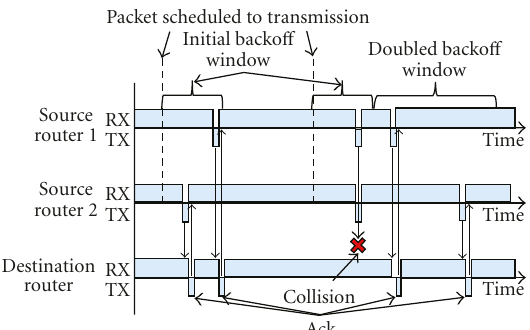
Figure 4: Router node channel access operation principle. The source routers 1 and 2 schedule packets for transmission simultane- ously. The first packets are sent successfully using an initial backo ff time. The second packets collide and are successfully retransmitted using a backo ff window twice the length of the